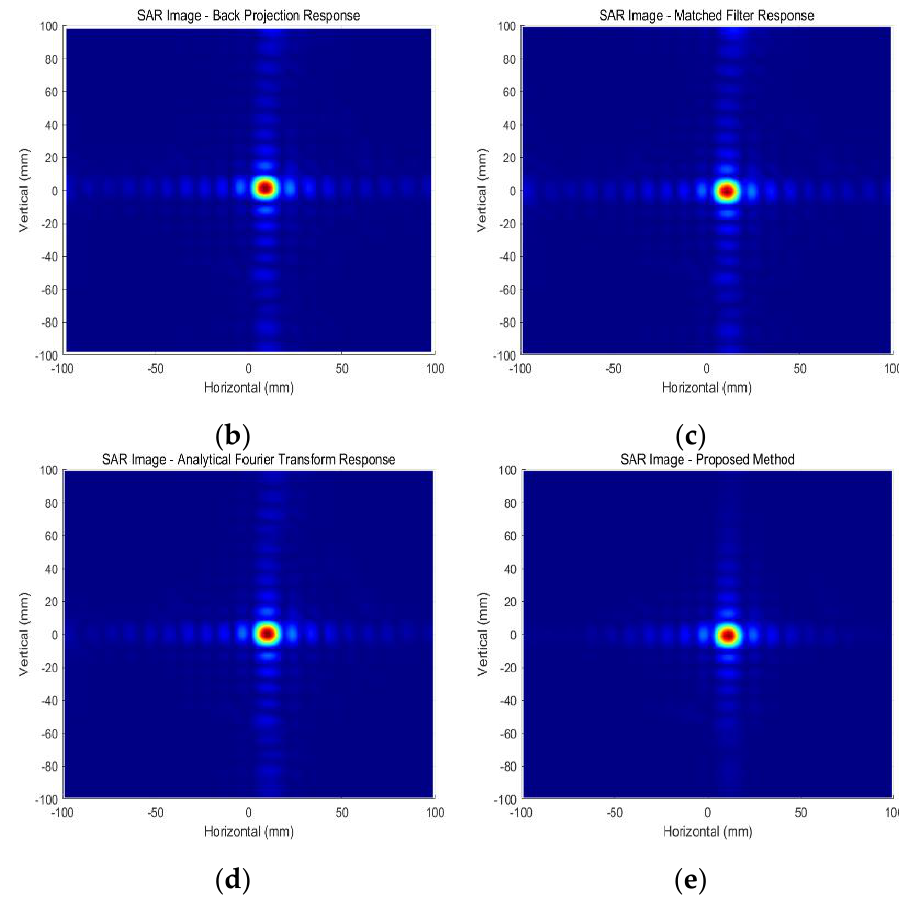
Figure 16. Point target: ( a ) corner reflector; ( b ) Back Projection; ( c ) Matched Filter; ( d ) Analytic Fourier Transform; ( e ) mmSight.